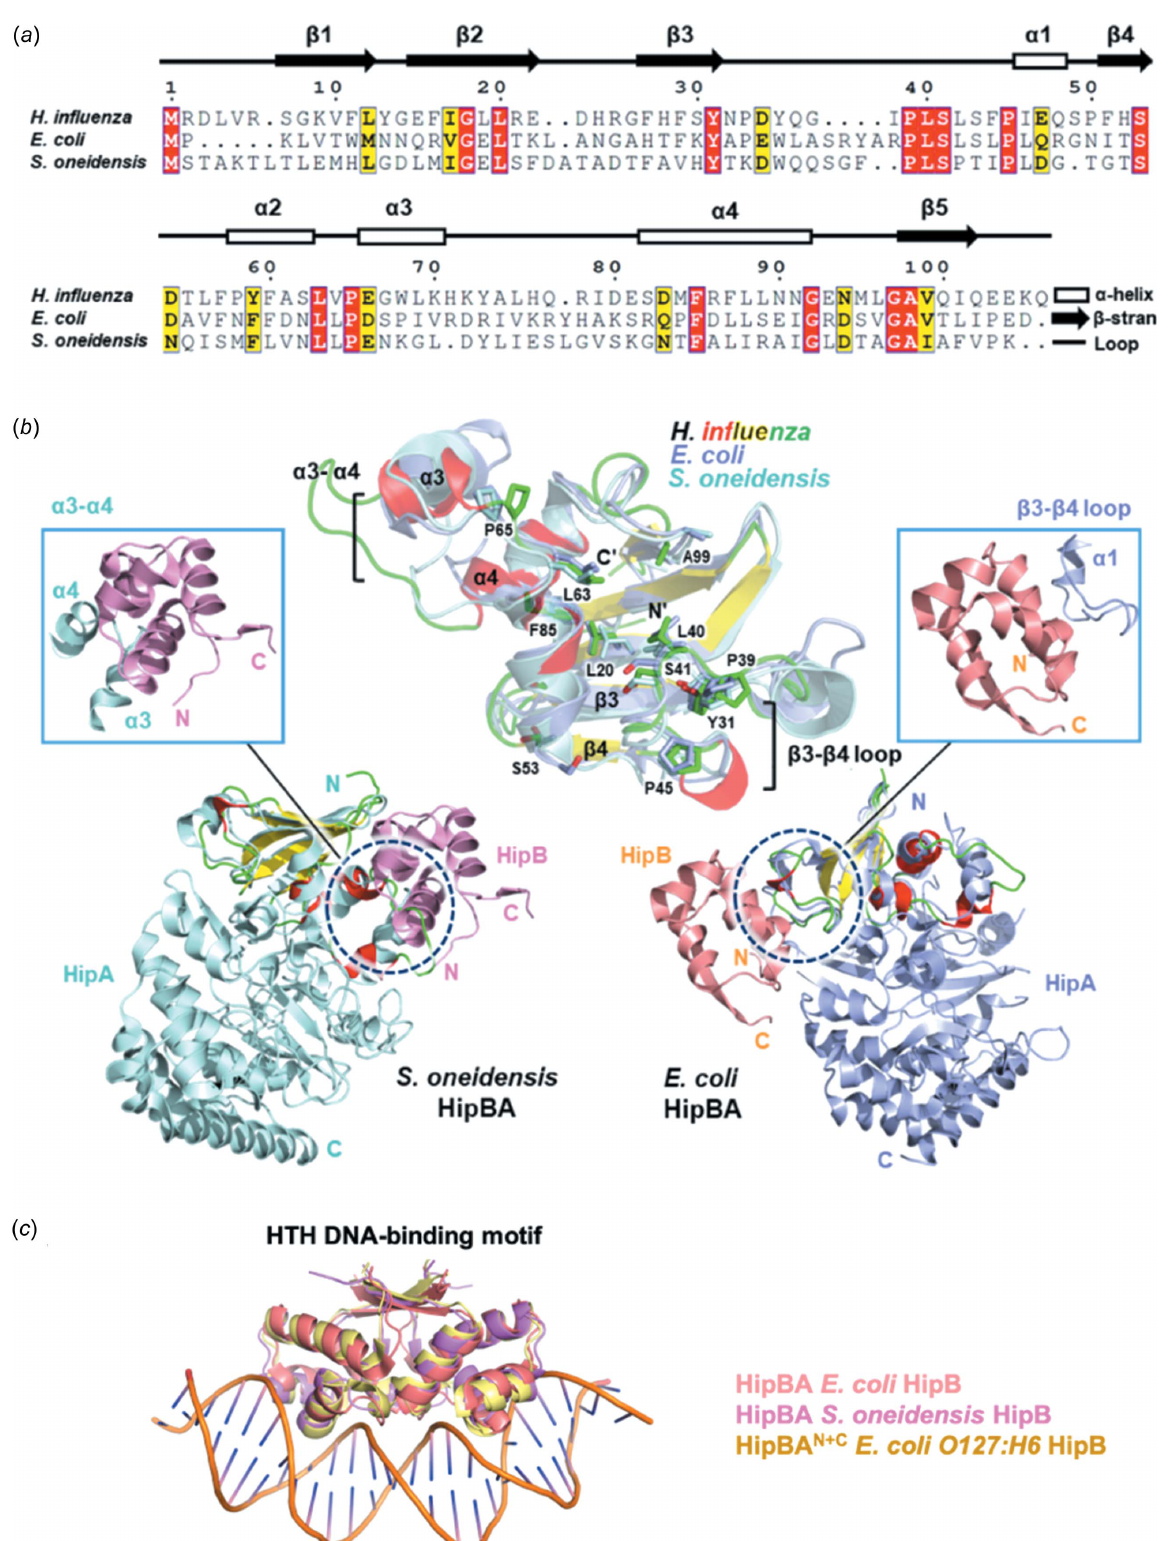
Figure 2 Comparative structural analysis of HipBA systems. ( a ) Structure-guided sequence alignment of H. influenzae HipA N with the N-terminal parts of other HipAs. The secondary structural organization of H. influenzae HipA N is displayed on the alignment. Conserved residues are highlighted in red and yellow. ( b ) Structural comparison of H. influenzae HipA N and HipBA systems from other organisms. Residues showing high conservation are marked in the overlay. HipBA binding interfaces of E. coli and S. oneidensis are identified in circles and enlarged in squares. ( c ) Structural comparison of HipB antitoxins from E. coli O127:H6 (PDB code: 7ab3) and S. oneidensis (PDB code: 4pu3) using E. coli HipB antitoxin bound to the DNA (PDB code: 5k98) structure as